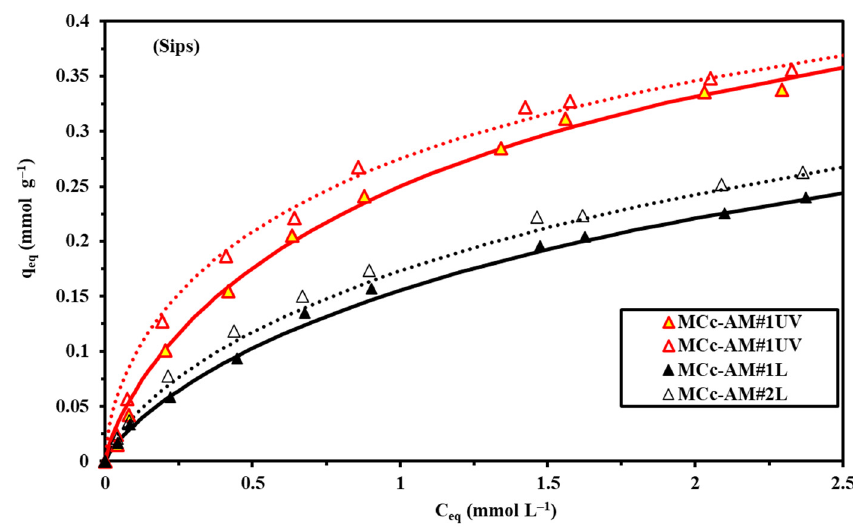
Figure 7. Sorption isotherms (Sips) model of the MCc sorbent under visible light and UV .